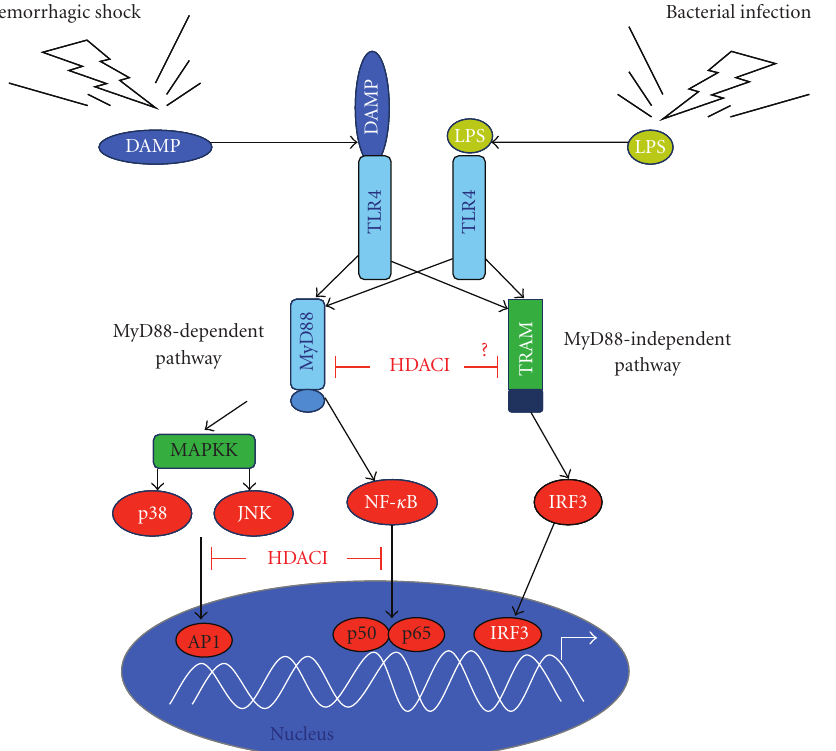
Figure 3: TLR4 signaling – a converged immune response pathway for hemorrhagic shock and septic shock. TLR4 not only serves as a key sensor of pathogen-associated molecular patterns (PAMPs) but also is proposed recently to act as a receptor for some endogenous molecules called “alarmins”. HDACIs block TLR4 signaling at multiple steps; therefore, they can inhibit immune response for both hemorrhagic shock and septic